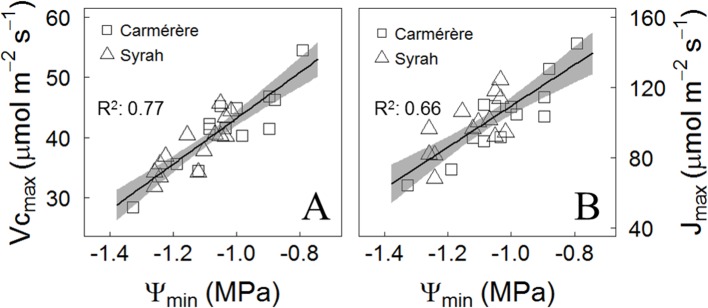
Post-drought effects on the photosynthetic performance. (A) Response of Maximum rate of carboxylation and (B) Maximum rate of electron transport at photosynthetically active radiation of 1,000 μmol m-2 s-1 to the mean of two lowest values of Ψmds (Ψmin) registered for each plant over the season. The determination coefficient (R2) is presented.